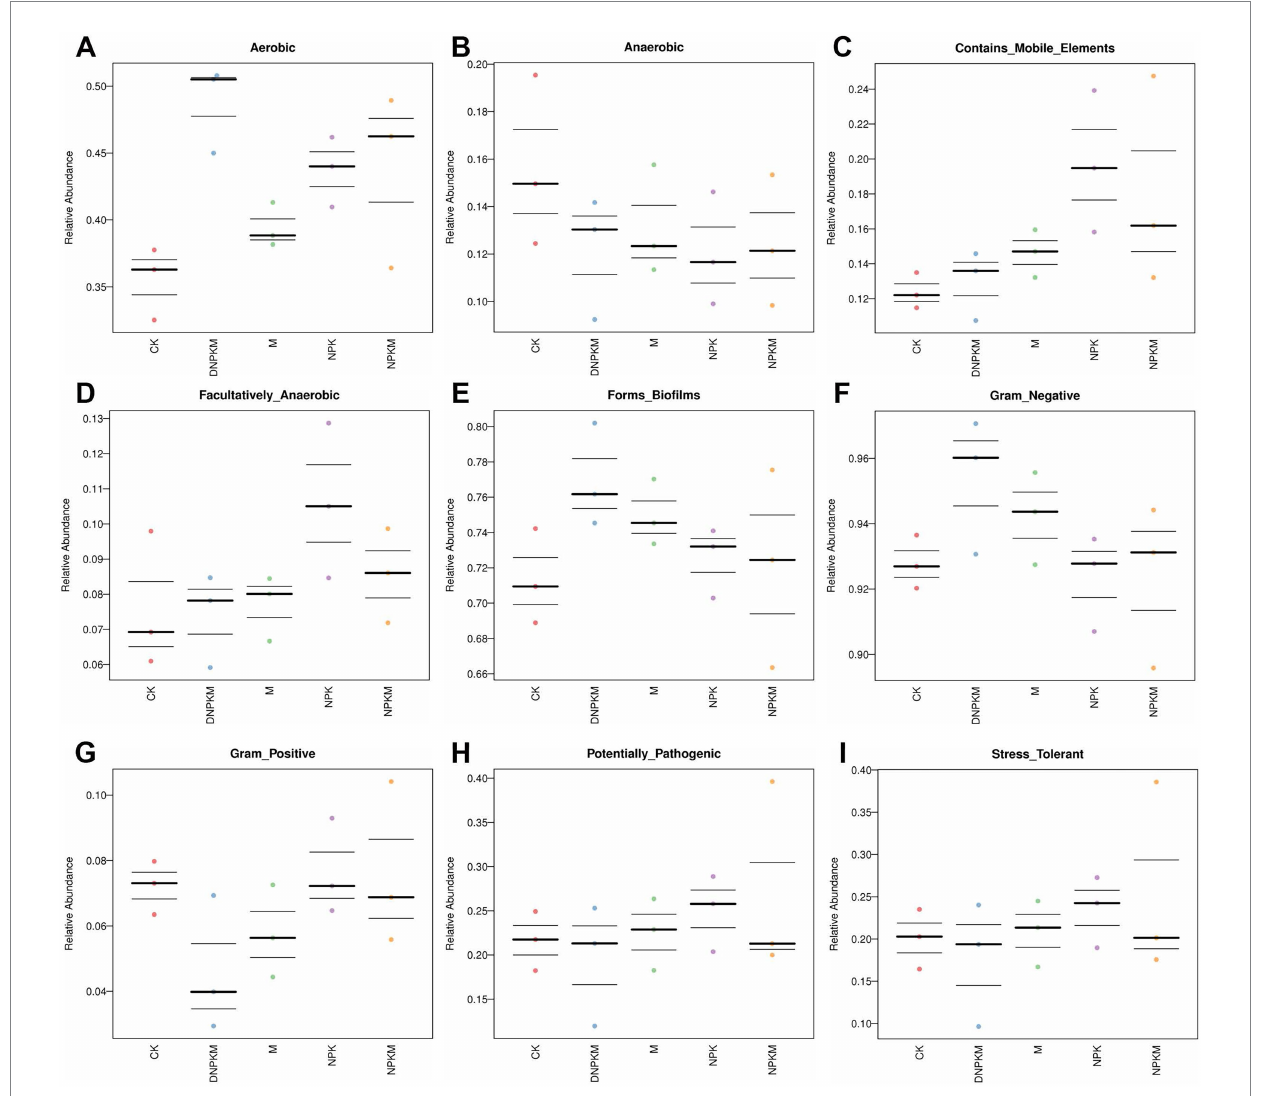
FIGURE 4 Chart analysis through BugBase software, the head is the function prediction of